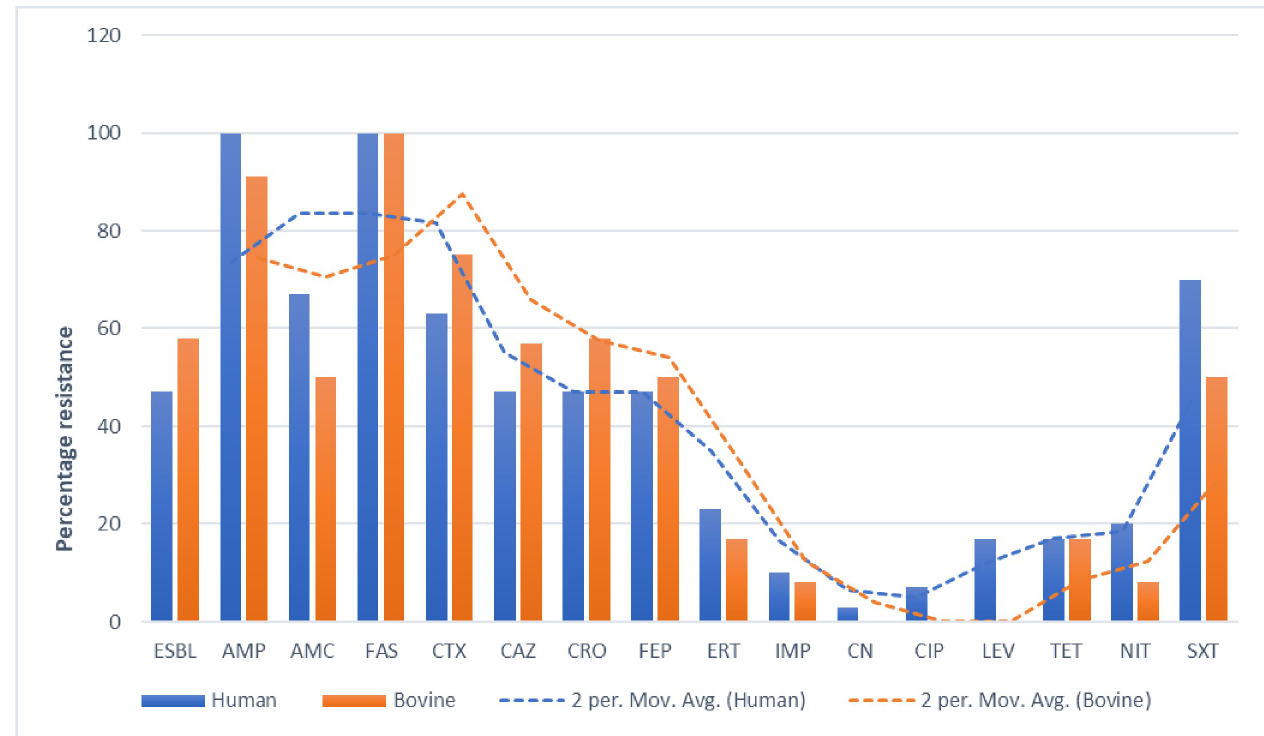
Fig 2. Phenotypic antibiotic resistance patterns in humans and cattle. ESBL = Extended Spectrum β -lactamase, AMP = ampicillin, AMC = amoxicillin/ clavulanic acid, FAS = cefazolin, CTX = Cefotaxime, CAZ = ceftazidime, CRO = ceftriaxone, FEP = cefepime, ERT = ertapenem, IMP = imipenem, CN = gentamicin CIP = ciprofloxacin, LEV = levofloxacin, TET = tetracycline, NIT = nitrofurantoin, SXT = trimethoprim/sulphurmethoxazole.